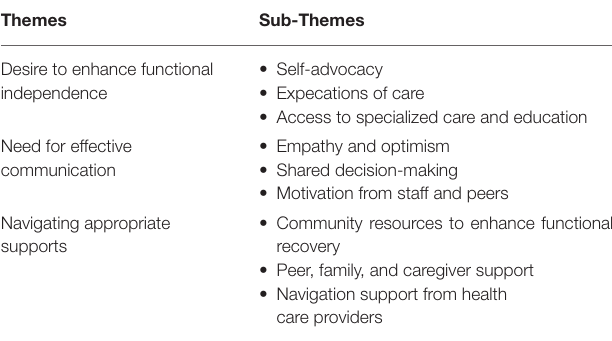
TABLE 1 | Participant characteristics. TABLE 2 | Thematic framework underlying the SCI patient experience of in-hospital